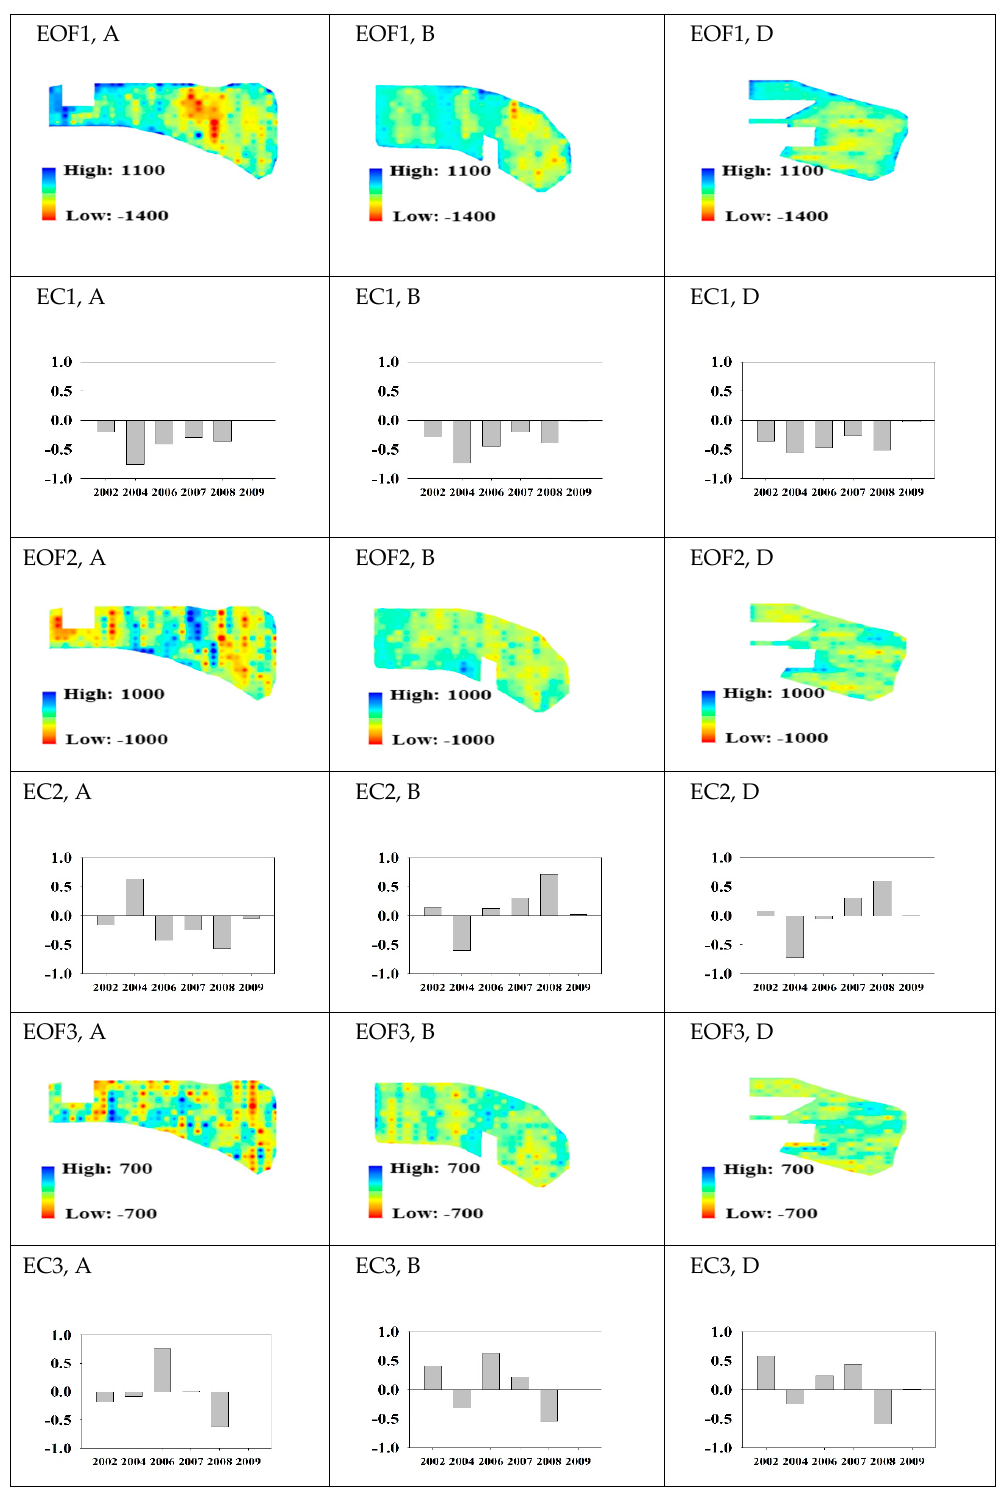
Figure 2. Empirical orthogonal functions EOF1, EOF2, and EOF3 (maps) and the corresponding expansion coefficients EC1, EC2, and EC3 (bar graphs) for corn yields at fields A, B, D at the OPE3 site.